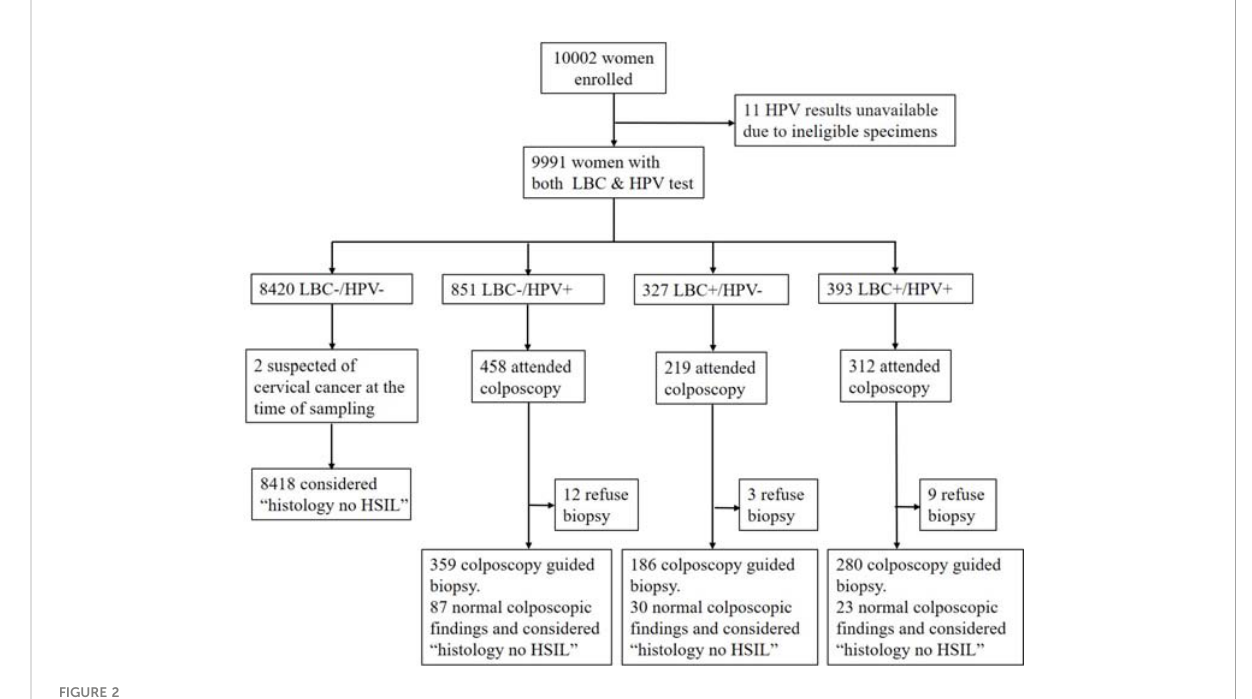
FIGURE 2 Flow diagram of the study